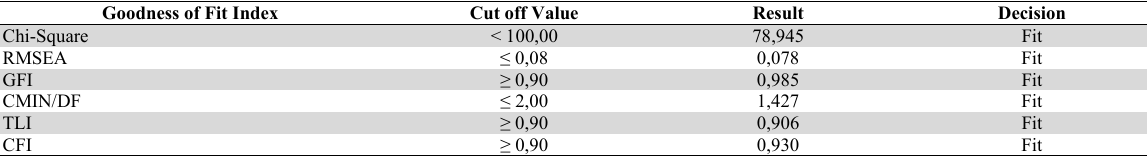
Results of Measurement Model Evaluation